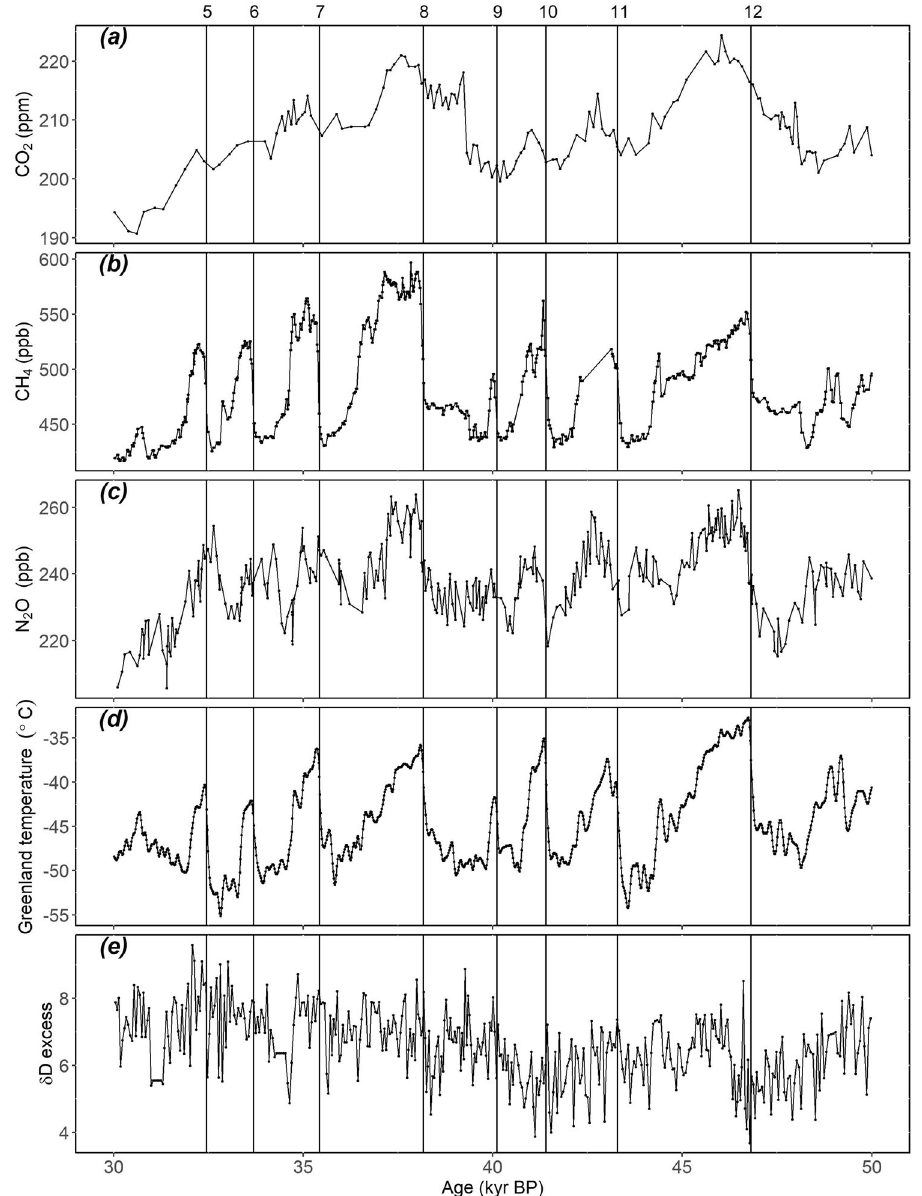
Fig. 1 Ice-core records between 50 and 30 ka. Changes in ( a ) CO 2 , ( b ) CH 4 , ( c ) N 2 O, ( d ) Greenland temperature, and ( e ) δ D excess. The vertical lines show the of fi cial start dates of the numbered D-O warming events. All data are on the AICC2012 timescale (BP